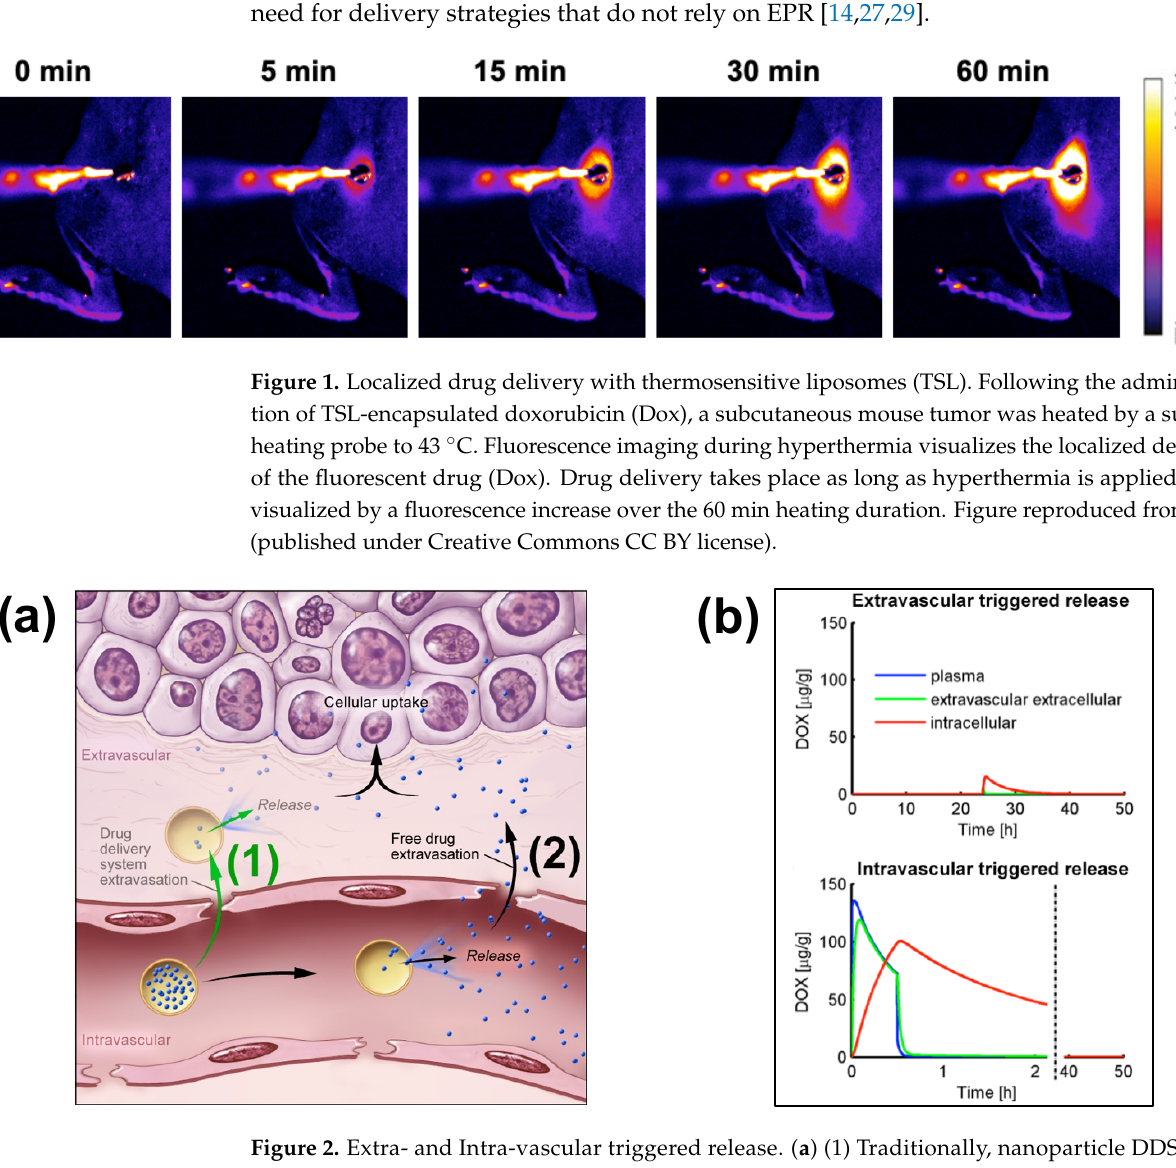
Figure 1. Localized drug delivery with thermosensitive liposomes (TSL). Following the administration of TSL-encapsulated dox- 57 orubicin (Dox), a subcutaneous mouse tumor was heated by a surface heating probe to 43 °C. Fluorescence imaging during hyper- thermia visualizes the localized delivery of the fluorescent drug (Dox). Drug delivery takes place as long as hyperthermia is ap- plied, here visualized by a fluorescence increase over the 60 min heating duration. Figure reproduced from [30] (published under Creative Commons CC BY license).